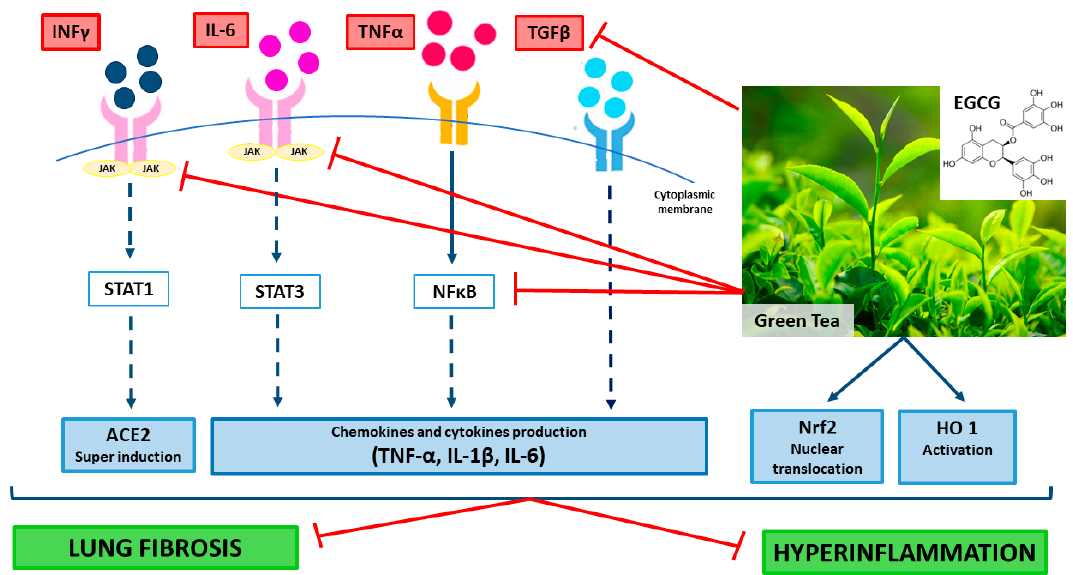
Figure 1. Mechanisms of the potential beneficial effects of green tea extract and epigallocatechin-3- Figure1. Mechanismsofthepotentialbeneficiale ff ectsofgreenteaextractandepigallocatechin-3-gallate gallate (EGCG) in coronavirus disease 2019 (COVID-19) patients. (EGCG) in coronavirus disease 2019 (COVID-19)